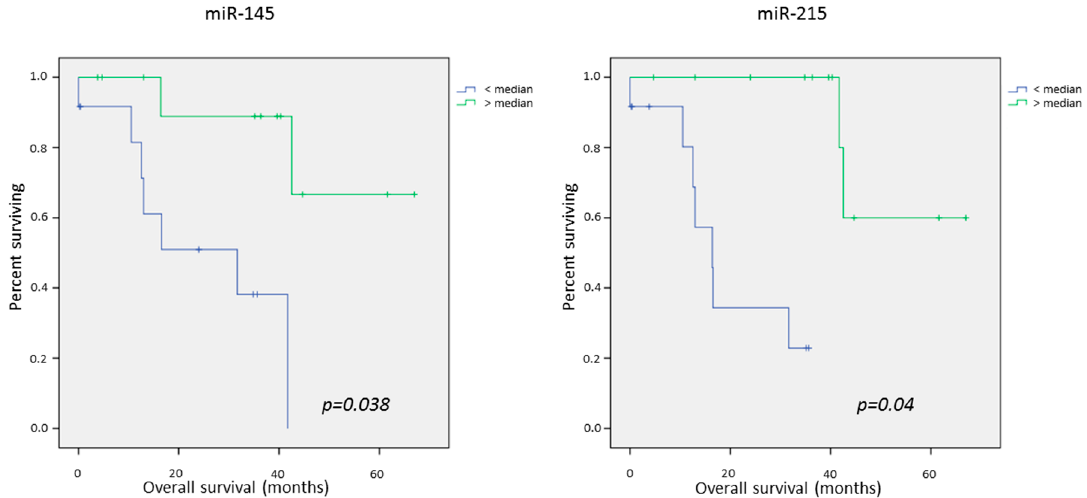
Figure 4. Kaplan–Meier curves of significant factors (miR-145 and miR-215 in the host tissue of the liver metastases) for overall survival in lung and liver Metastases.